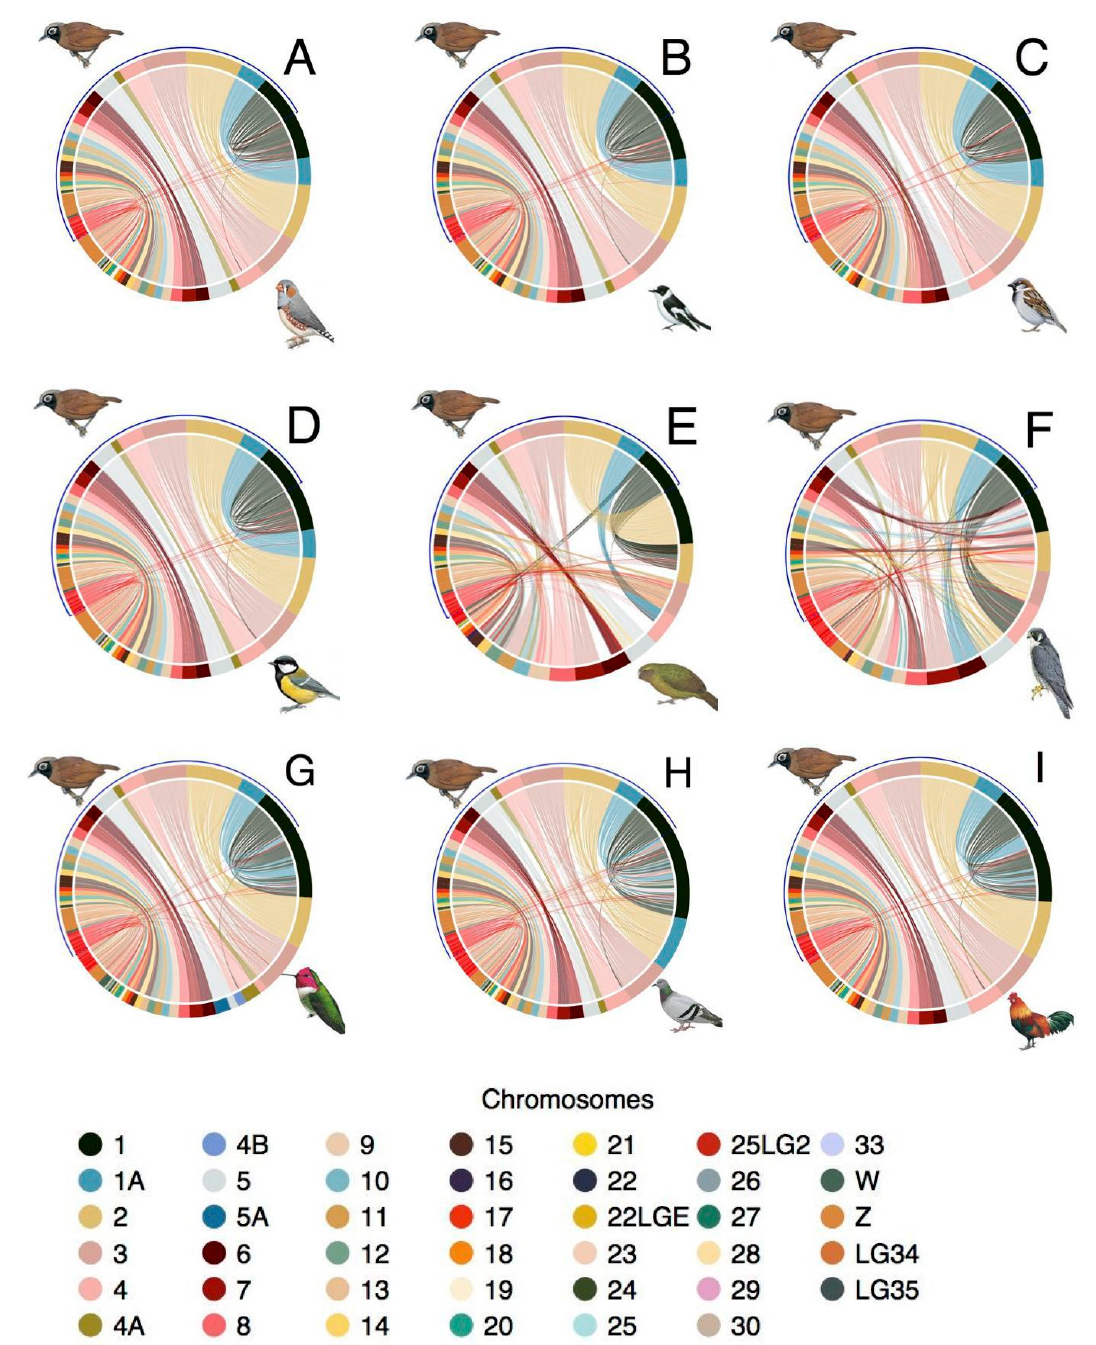
Figure 3. Synteny plots between single-reference-based genome assemblies (lower-half of the circle, reference taxa represented by bottom right figures: Taeniopygia guttata ( A ); Ficedula albicollis ( B ); Passer domesticus ( C ); Parus major ( D ); Strigops habroptila ( E ); Falco peregrinus ( F ); Calypte anna ( G ); Columba livia ( H ); Gallus gallus ( I )) and multiple-reference-based genome assembly (top-half circle highlighted by blue line, represented by top left figure of Rhegmatorhina melanosticta ). The red segments at the end of the single-reference and beginning of the multiple-reference genomes correspond to unplaced scaffolds.